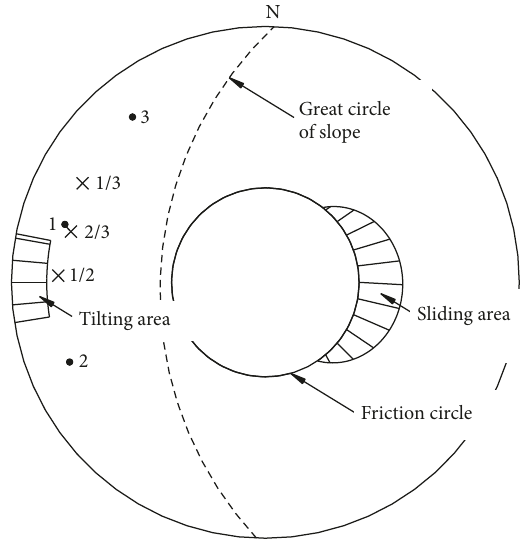
Figure 3: Stereographic projection analysis of slope failure mode.